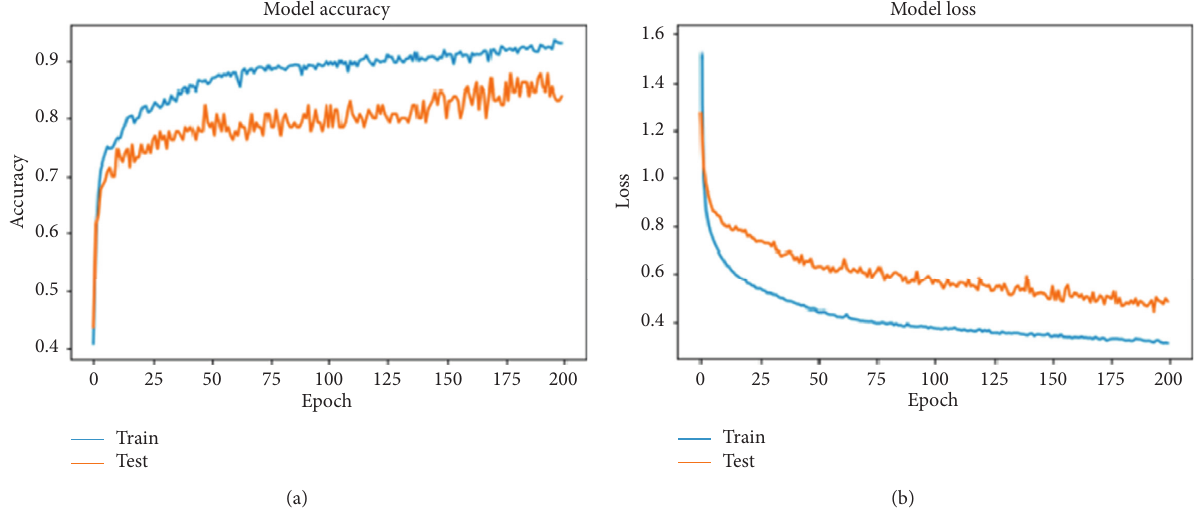
Figure 14: Model accuracy and model loss for M-learning model 3. (a) Model 3 accuracy. (b) Model 3 loss.